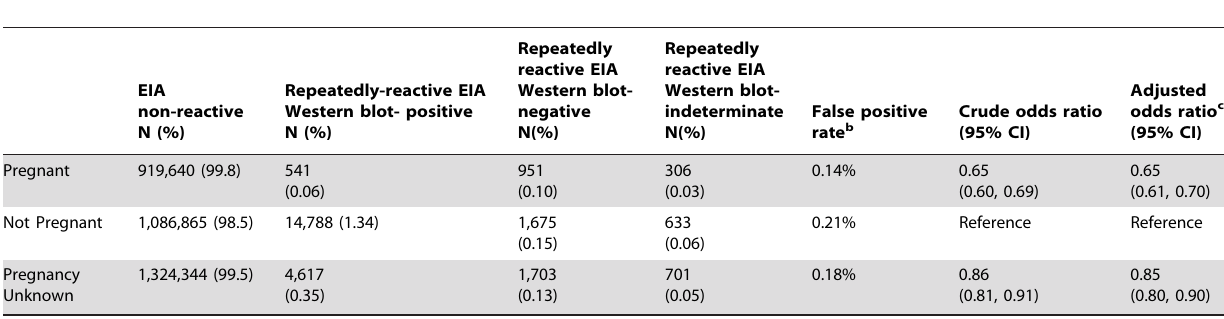
Table 2. HIV test results, false-positive rate and risk of false-positive result, by pregnancy status a , national commercial laboratory, July 2007 to June 2008.